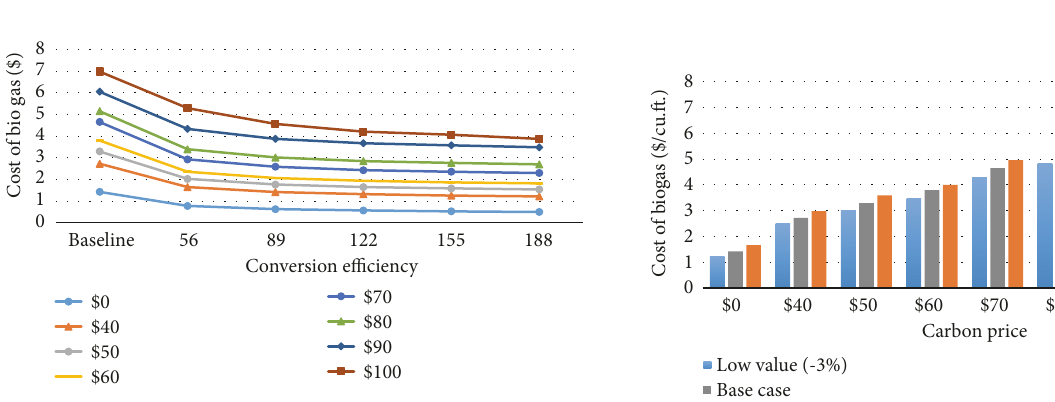
Figure 8: Cost of biogas by carbon price and conversion efficiency (m 3 /ton).